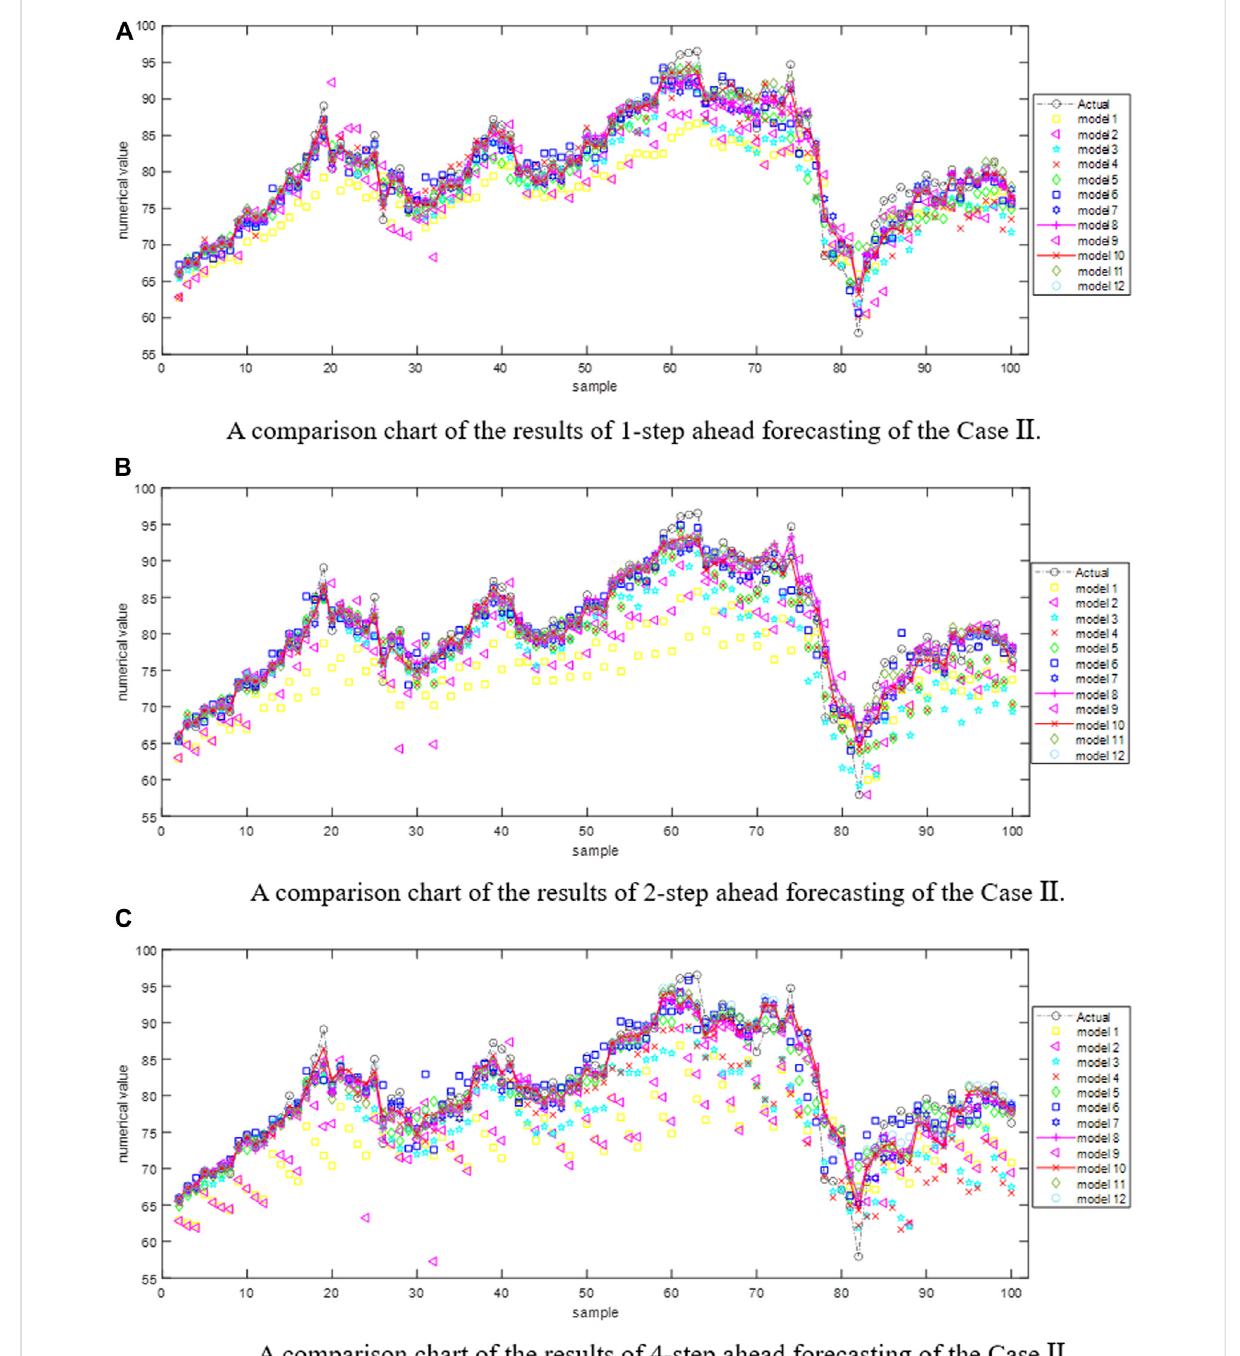
FIGURE 4 A comparison chart of the results of multi-step ahead forecasting of the Case